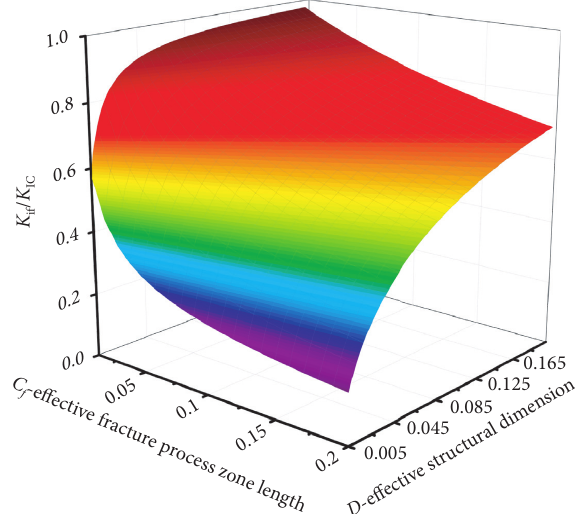
Figure 12: Three-dimensional surface plot as a function of c